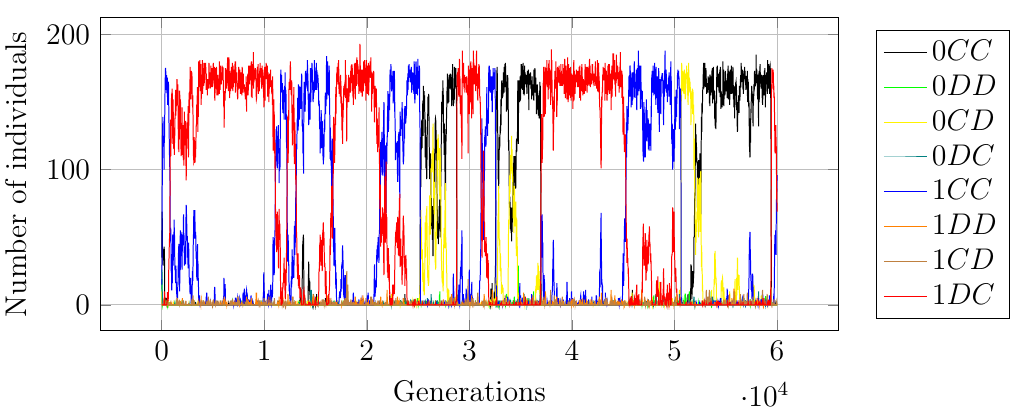
Figure 3: Time series for simulation run showing all eight strategies, c = 0 . 05 , ρ = 200.